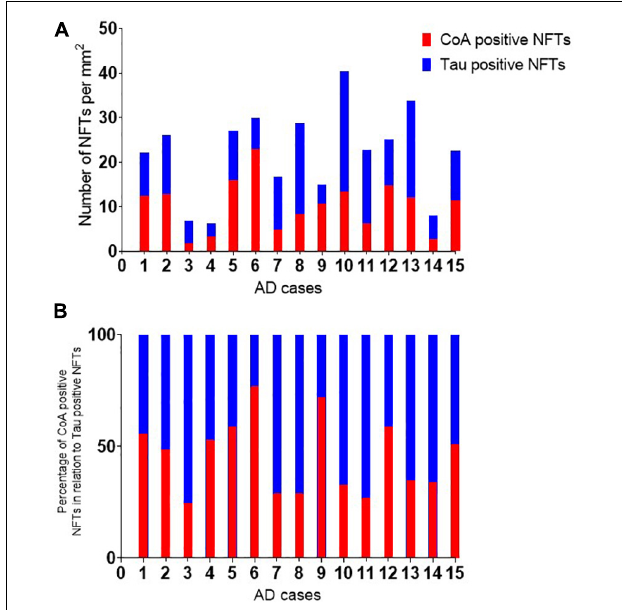
FIGURE 2 | Quantitative analysis of Tau and CoA positive neurofibrillary tangles. The number of neurofibrillary tangles (NFTs) positive with tau and CoA immunohistochemistry were quantitated in the frontal cortex of Alzheimer’s disease cases. The number of NFTs were counted in a region of interest in the frontal gray matter and corrected per mm 2 . (A) The percentage of CoA NFTs relative to the number of tau positive NFTs are shown in panel (B)